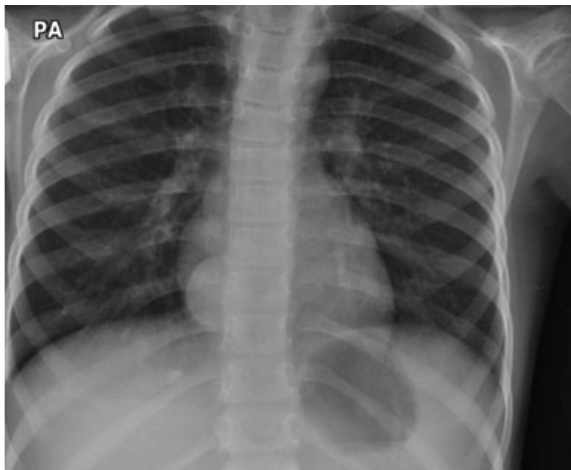
Fig. 1 Chest X-ray showing a lesion in the right hemithorax situated within the right atrial shadow.